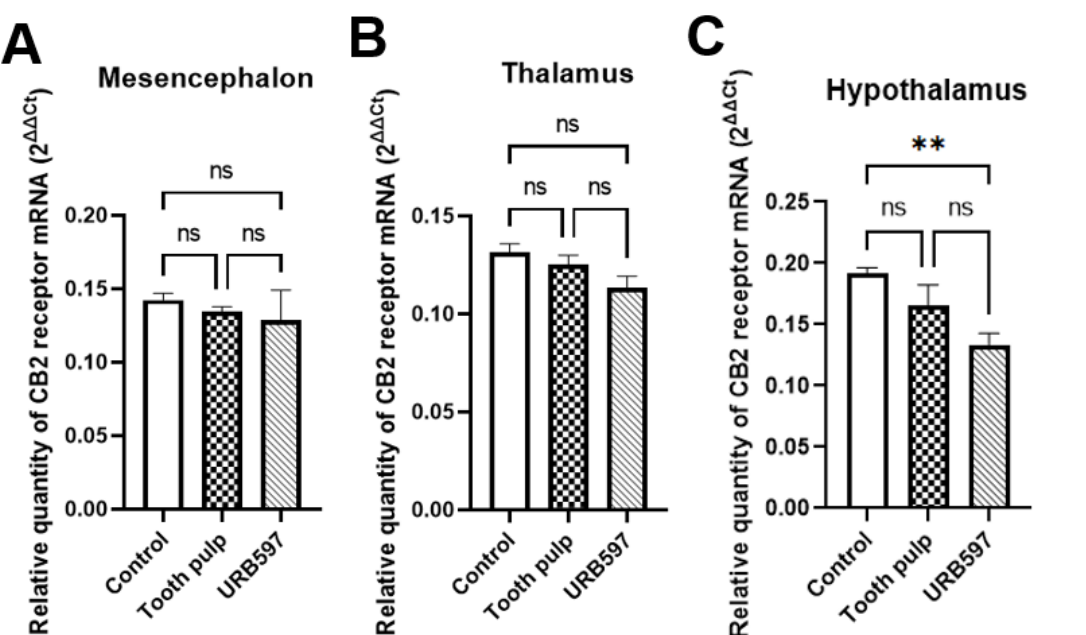
Figure 6. Quantitative RT-PCR analysis of CB2 receptor mRNA expression in ( A ) mesencephalon, ( B ) thalamus and ( C ) hypothalamus induced by tooth pulp and URB597 treatment. The data represent mean ± SEM of 6 rats per group. Statistical significance was assessed using one-way ANOVA and a post hoc multiple comparison Tukey test. Asterisks denote significance level (** p < 0.01, ns—not statistically